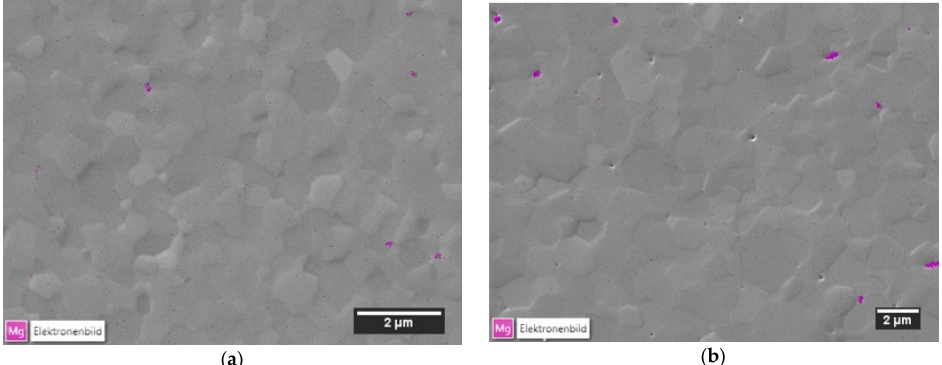
Figure 3. Field emission scanning electron microscopy (FESEM) images of the polished cross section of the sample: ( a ) O1 [6]; ( b ) HT1350; ( c ) HT1400.